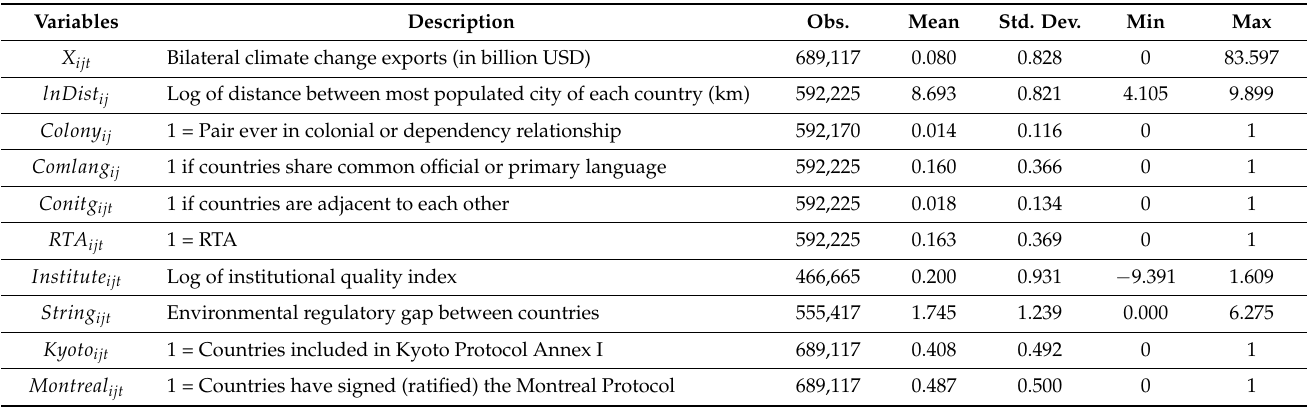
Table 4. Descriptive Statistics